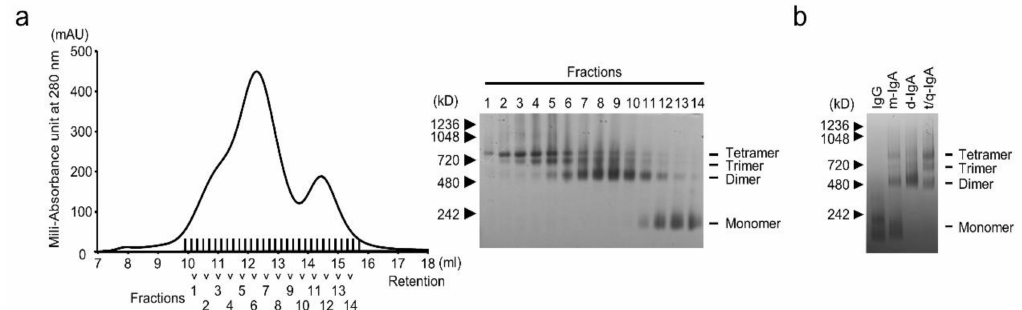
Figure 1. Purification of ch-rM2ss23 IgA. ch-rM2ss23 IgA antibodies were fractionated by gel filtration chromatography (GFC) with a Superose 6 10 / 300 GL column. A chromatogram demonstrating absorbance at 280 nm (shown in milli-absorbance units (mAU)) reveals two major peaks ( a , left panel). Fractions covering the two peaks were subjected to blue native polyacrylamide gel electrophoresis (BN-PAGE) ( a , right panel). Equal amounts (5 µ g) of purified ch-rM2ss23 IgG, m-IgA, d-IgA, and t / q-IgA were used for BN-PAGE ( b